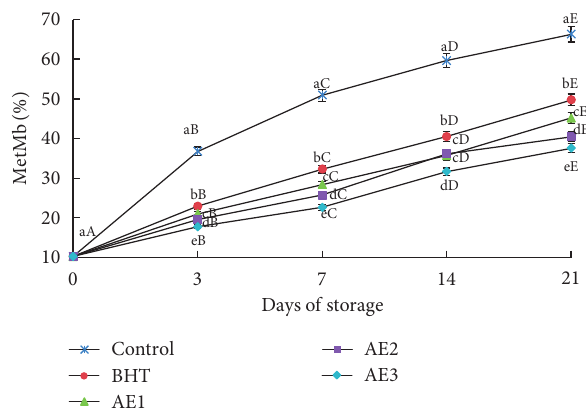
Figure 2: Effect of the aqueous pomegranate peel extract on MetMb (%) of minced beef meat during storage at 4 °